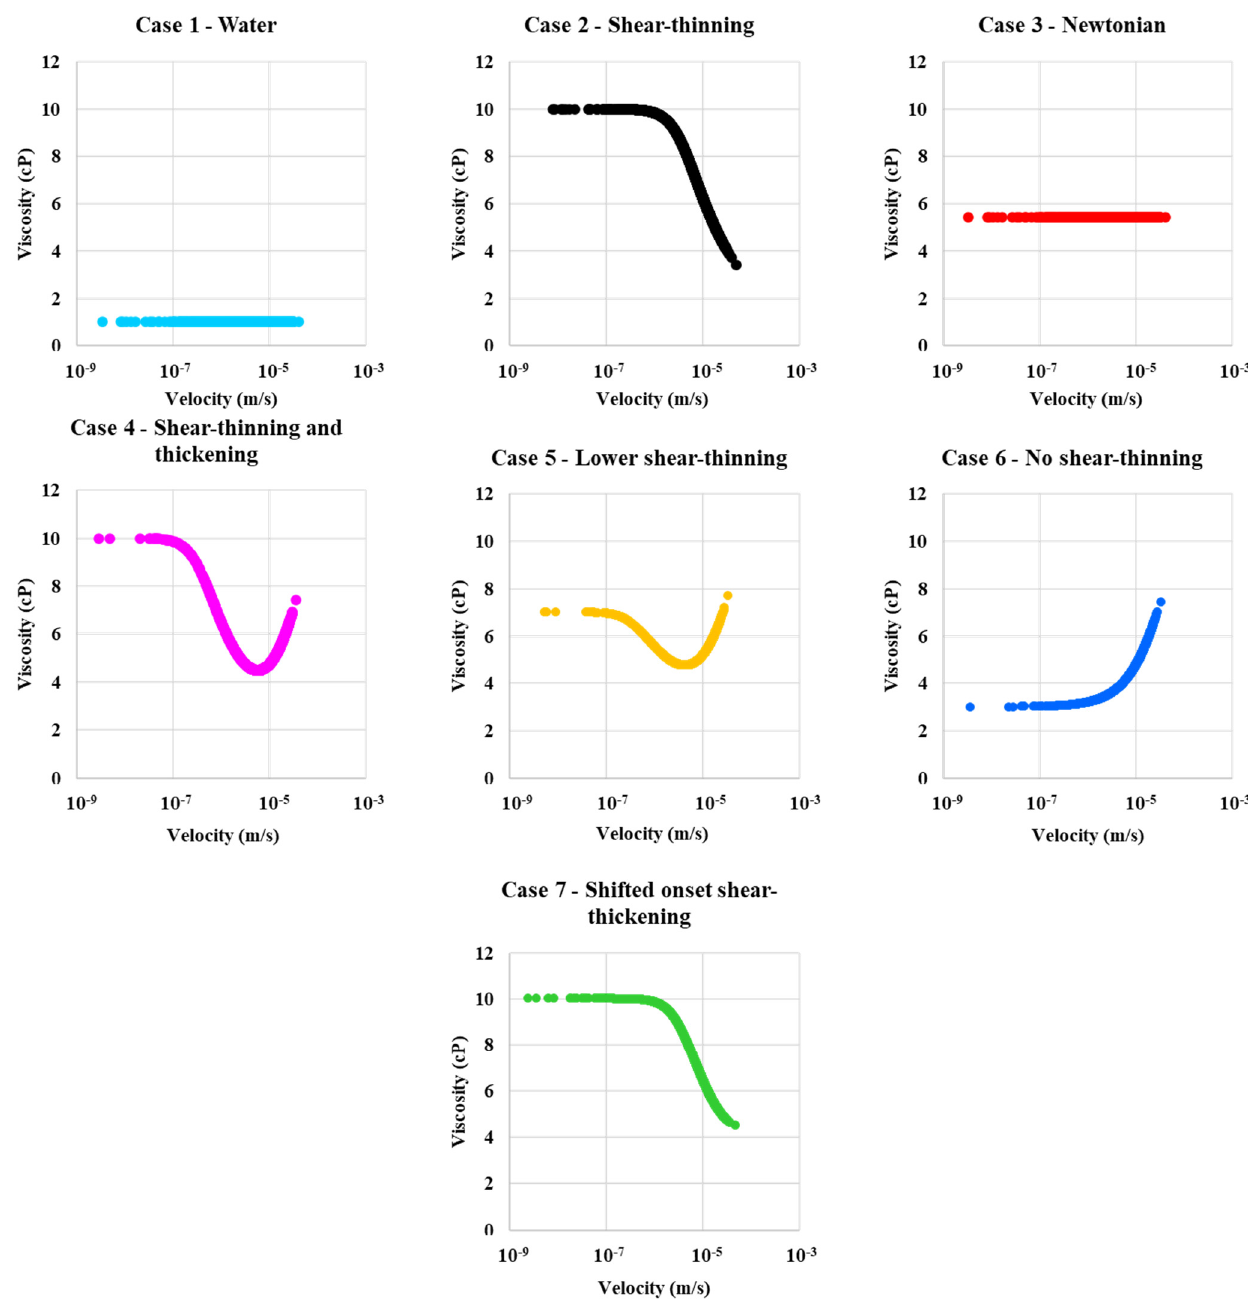
Figure 5. In-situ viscosity as a function of velocity for Case 1—water, Case 2—shear-thinning, Case 3—Newtonian, Case 4—shear-thinning and thickening, Case 5—lower shear-thinning, Case 6—no shear-thinning, and Case 7—shifted onset of a shear-thickening polymer.